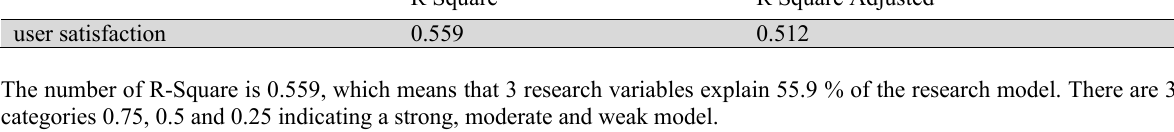
Table 3 R Square user satisfaction 0.559 0.512